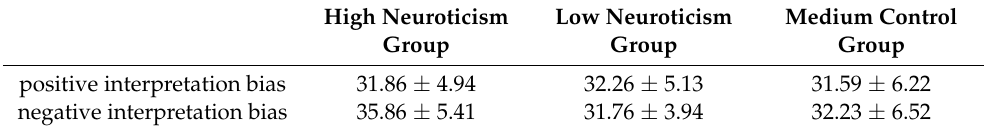
Table 8. Descriptive statistics of positive and negative interpretation biases. ( M ± SD ; Unit: %).